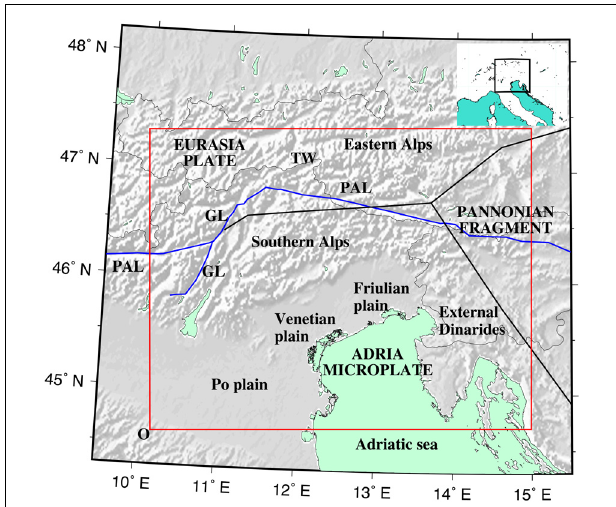
FIGURE 1 | Map that shows the area of the model (red rectangle). The origin point of the reference system of the model (O) is located at 10.2E, 45.6N, and the model extends 380 km to the East, 300 km to the North, and from 4 km a.sl. to 60 km b.s.l in depth. TW – Tauern Window. Blue line: main tectonic lineaments: PAL – Periadriatic Lineament; GL – Giudicarie line. Black lines: boundaries between Moho fragments, according to Brückl et al.